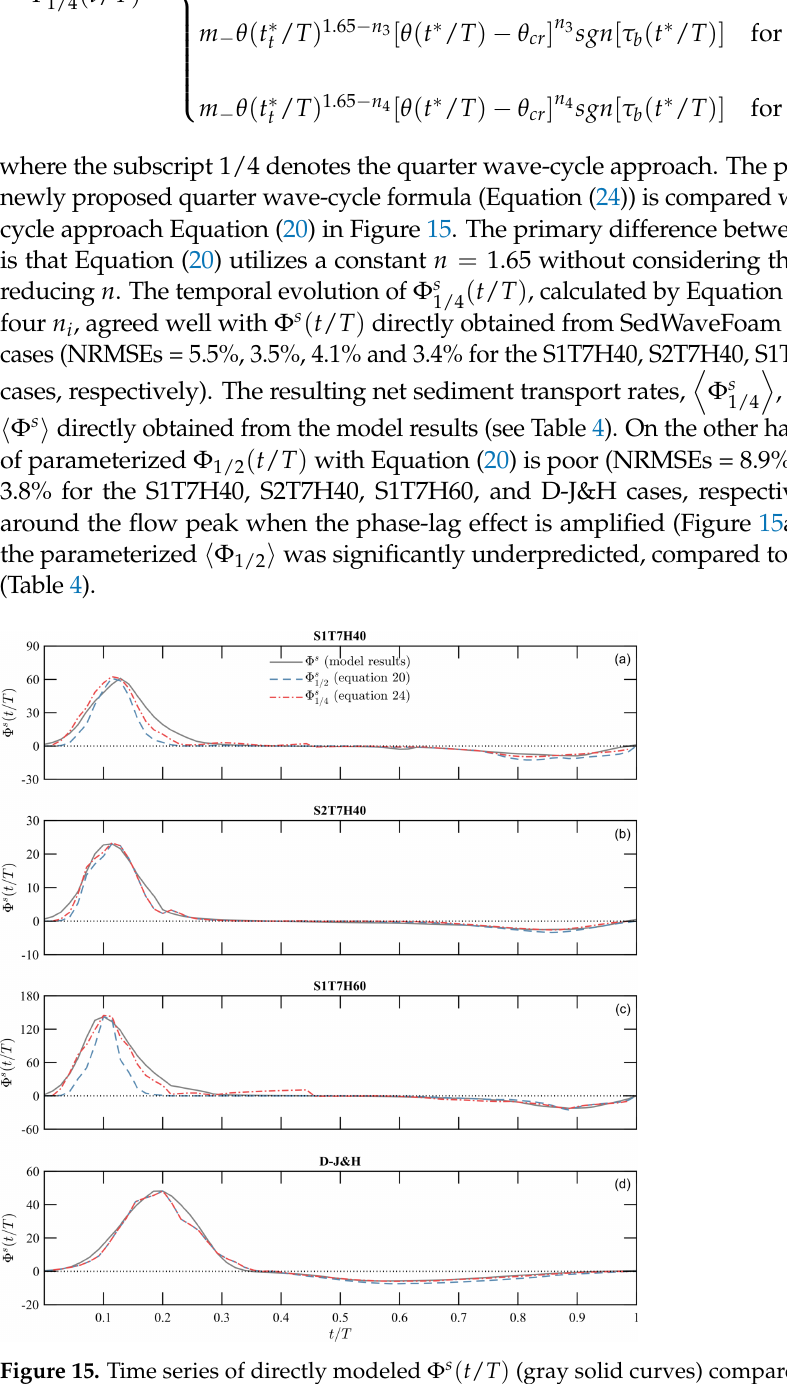
Figure 15. Time series of directly modeled Φ s ( t / T ) (gray solid curves) compared to those parame- terized by Equation (20) (blue solid curves) and Equation (24) (red dashed curves) for ( a ) S1T7H40, ( b ) S2T7H40, ( c ) S1T7H60 [46], and ( d ) D-J&H [43]